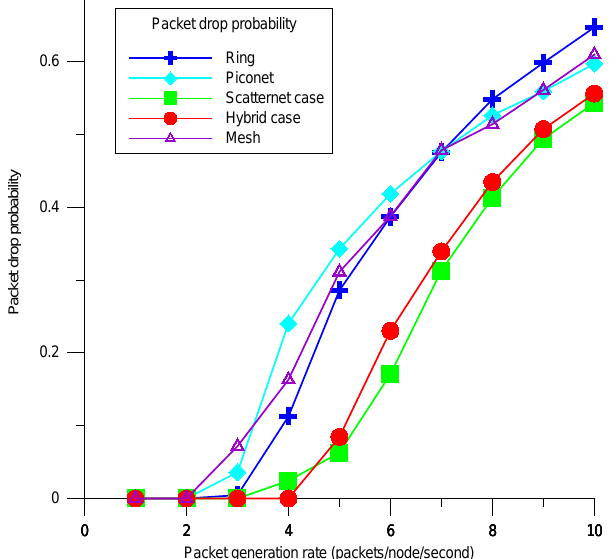
Figure 12. The packet drop probability (PDP) performance of the RMR algorithm.